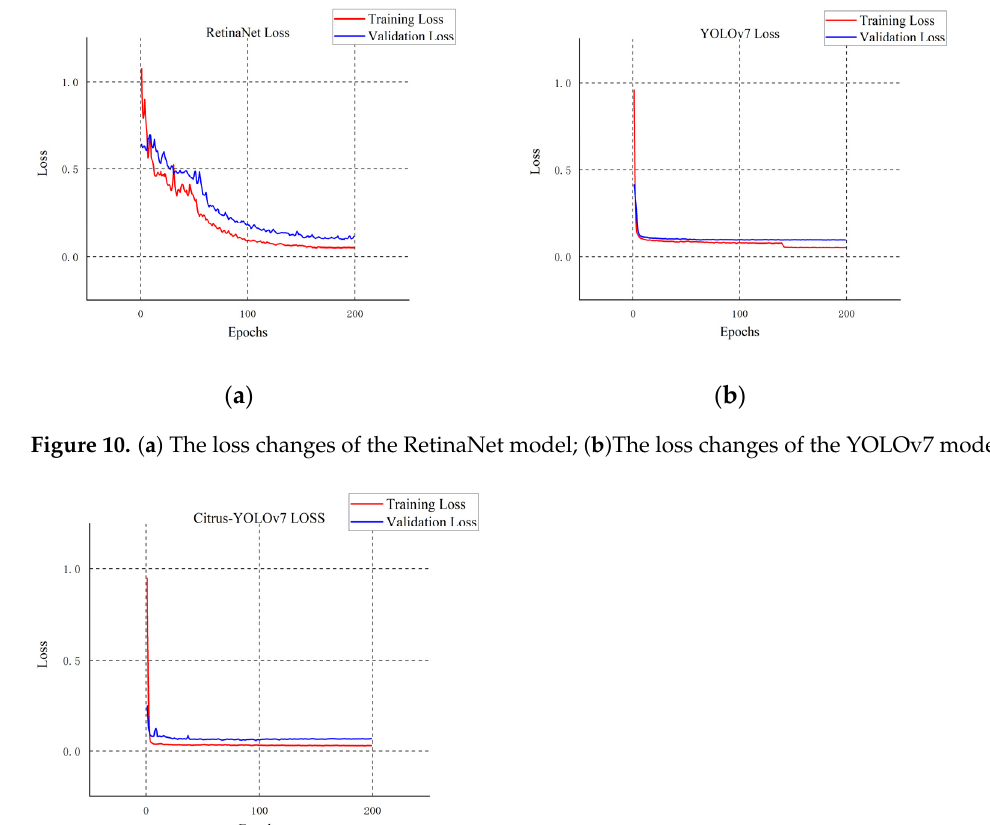
Table 2. Model performance table under multiple indicators.